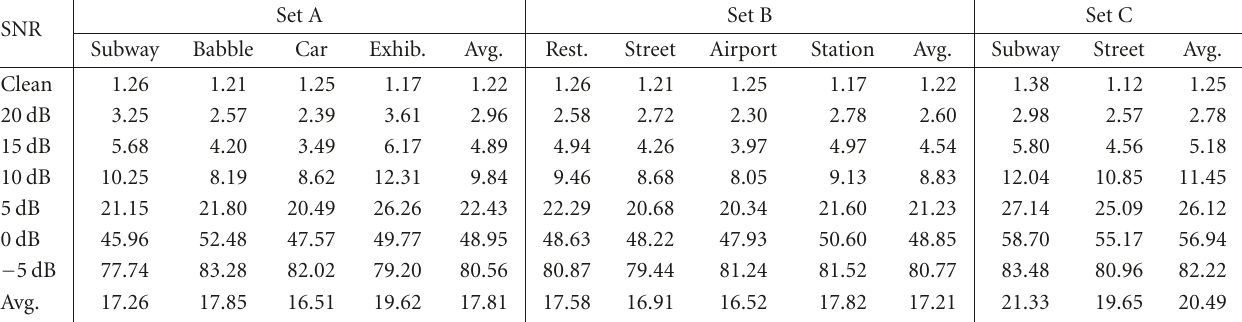
Table 6: Recognition results of the SE + HEQ compensation technique on the Aurora 2 task under clean-condition training (WER %). SNR Clean